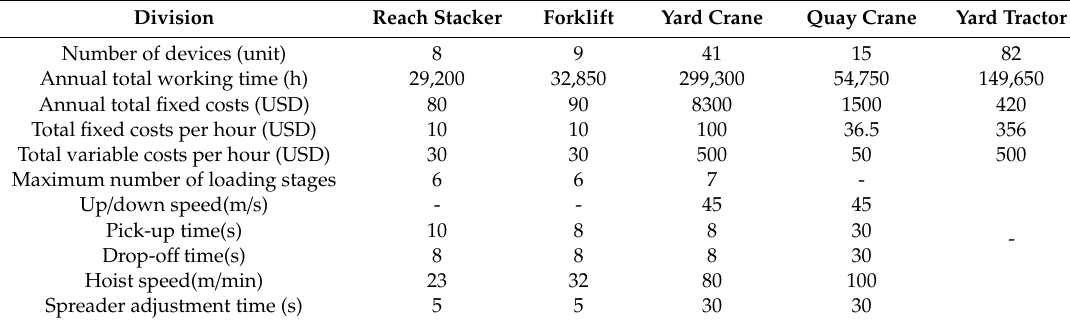
Table 1. Operation input data for port-container terminal equipment.